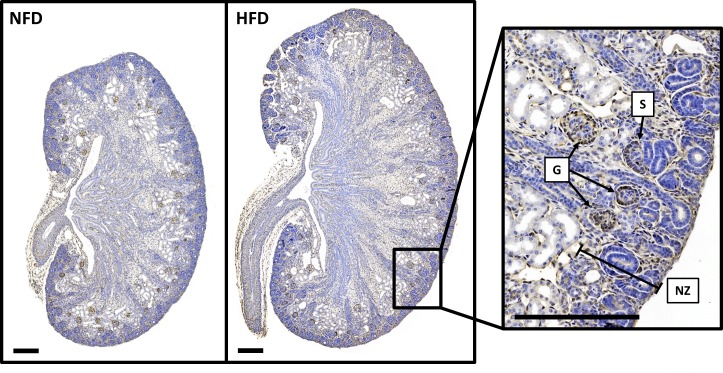
Representative images of sectioned E18.5 kidneys.Sections histochemically stained for PNA to identify glomeruli from the S-shaped stage to mature stage. Right panel highlights developing glomeruli at E18.5 at higher magnification. G = mature glomerulus, NZ = nephrogenic zone, S = S-shaped body. Scale bar = 200 μm.